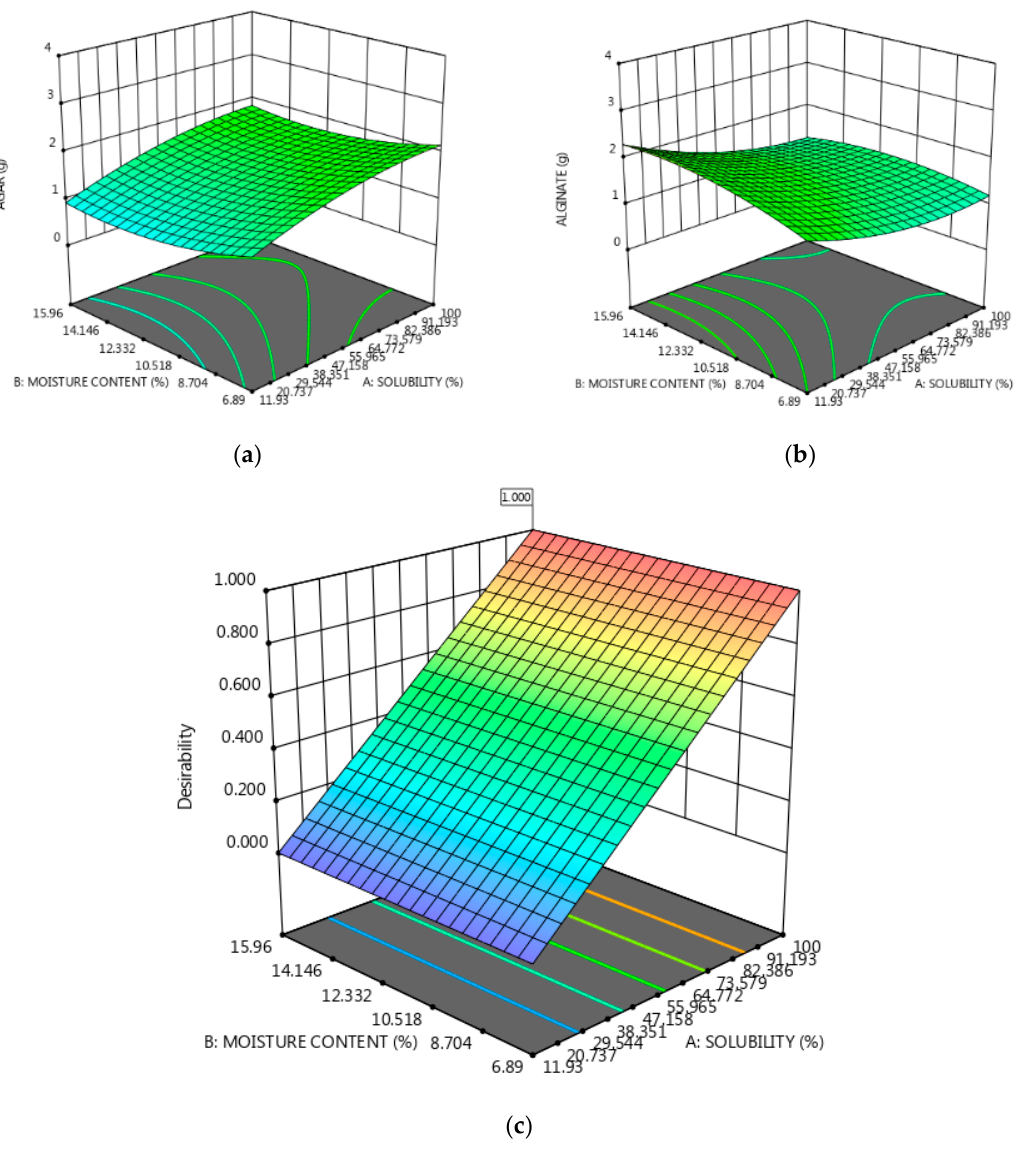
Figure 3. Optimizing the quantities used to create a completely soluble material. ( a ) agar content ( b ) alginate content; ( c ) desirability.